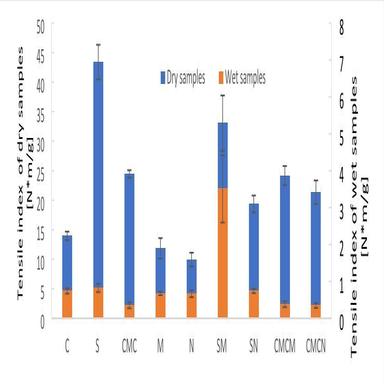
Tensile index difference diagrams for dry and wet papers.